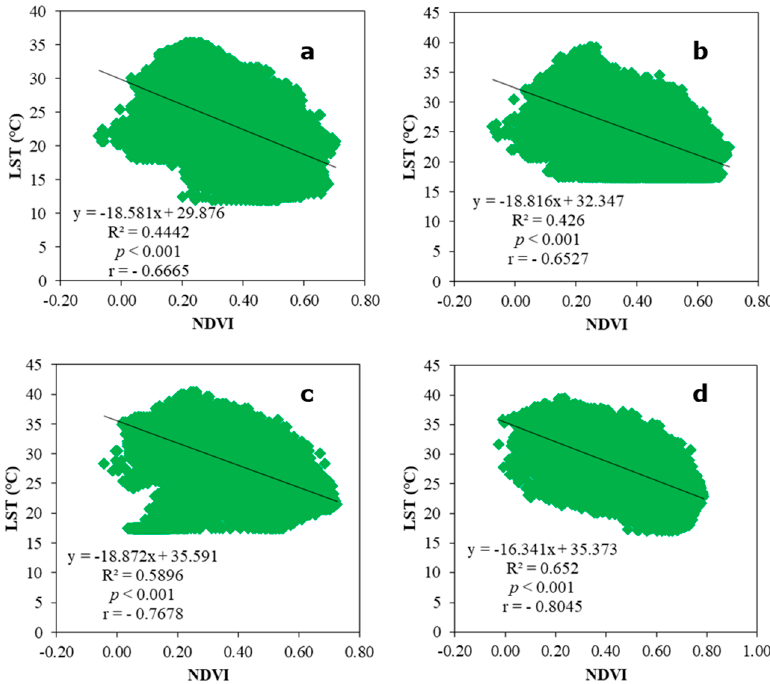
Figure A2. Statistical Scatter Plots between LST and NDVI for ( a ) 1988; ( b ) 1998; ( c ) 2008; ( d ) 2018.